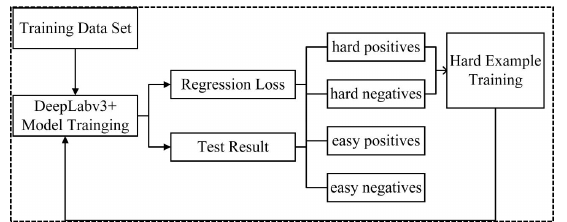
Figure1. Land cover change method with hard example